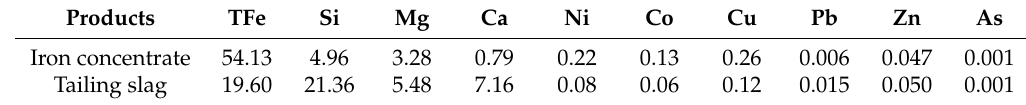
Figure 8. XRD patterns of the ( a ) separated iron concentrate and ( b ) tailing slag of the oxidized nickel slag at 12 wt.% CaO. Table 2. Components of the separated concentrate and tailing slag